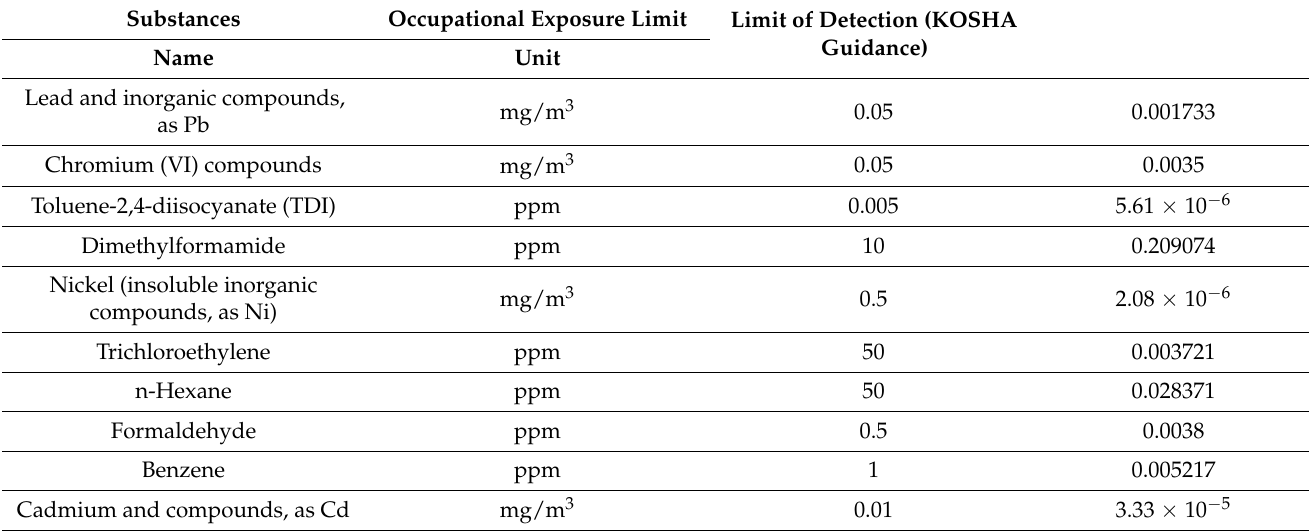
Table 9. Harmful substances to be maintained at or below permissible levels as of 2014 in